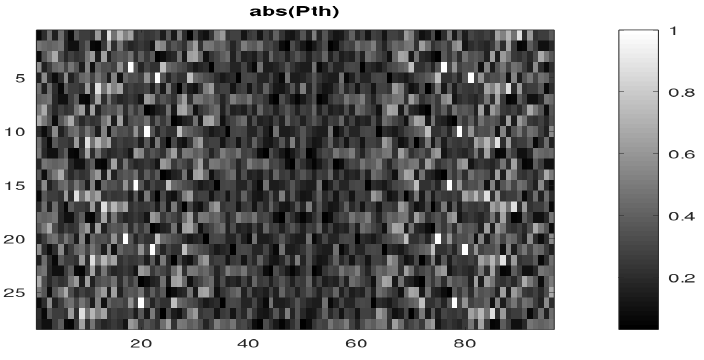
Figure 16. Theoretical mixture matrix P th